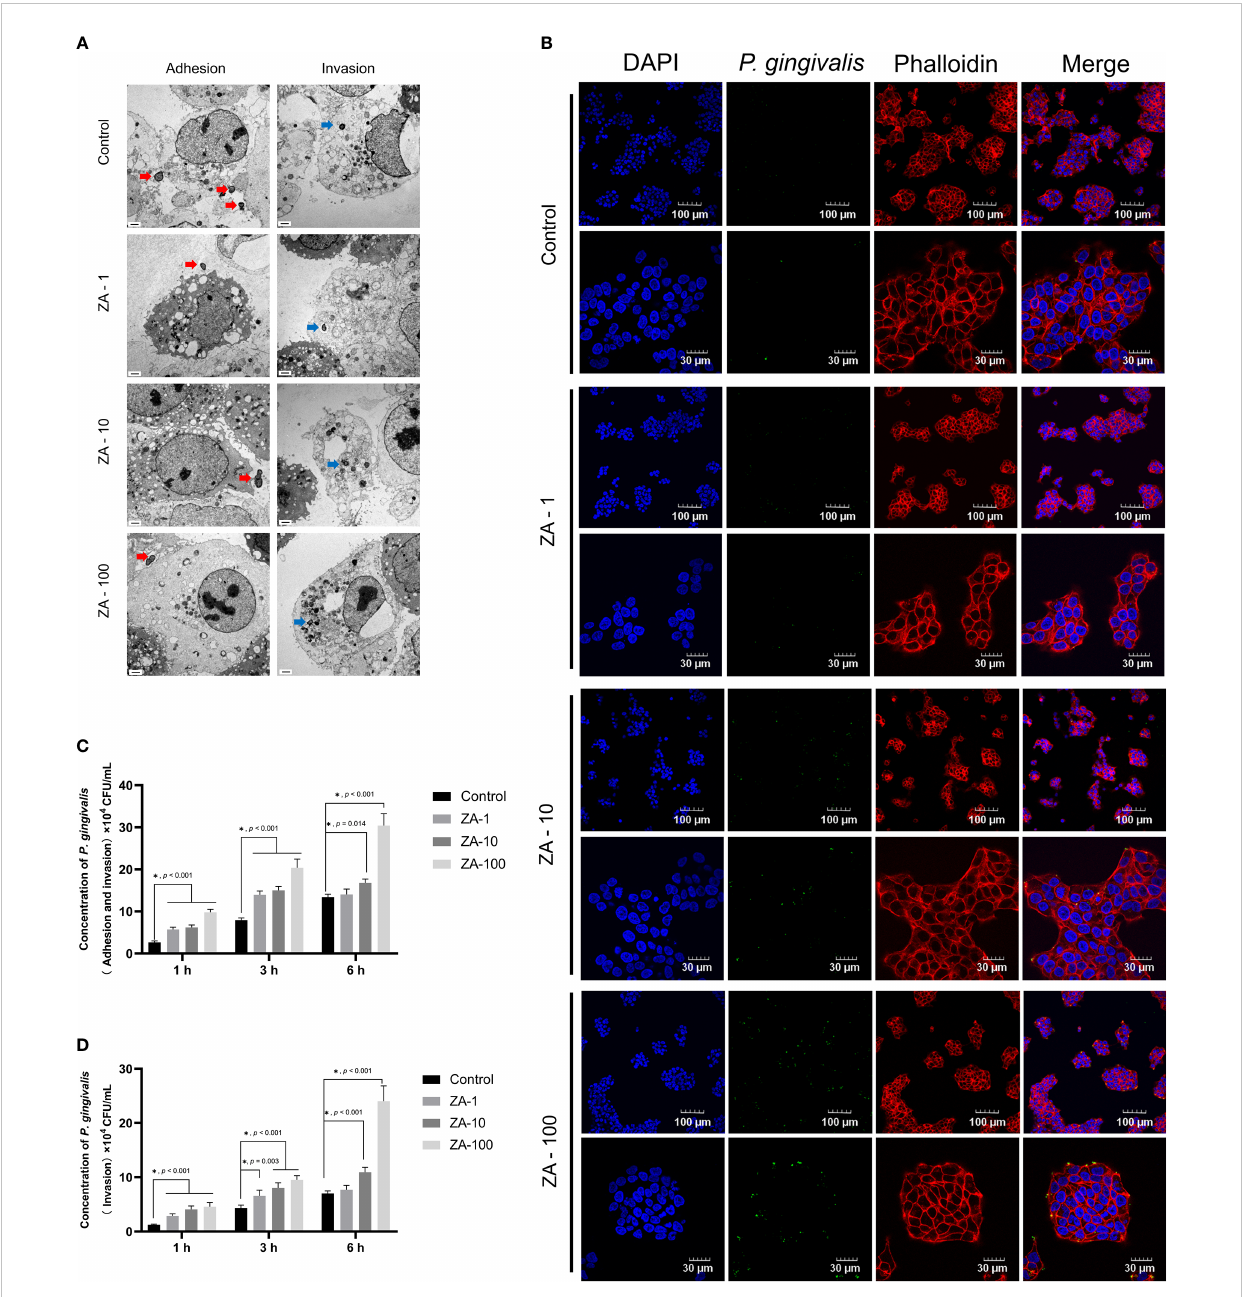
FIGURE 2 The process of P. gingivalis infecting HGECs in the presence of different concentrations of ZA in vitro . (A) The representative TEM images of in-vitro infection of HGECs by P. gingivalis of all groups. The red arrows indicate the P. gingivalis adhering to the surface of HGECs. The blue arrows indicate the P. gingivalis having invaded into HGECs. Scale bars = 1 m m. (B) The representative immuno fl uorescence images of P. gingivalis infecting HGECs for 6 h at different magni fi cations of all groups. The cell nucleus, blue fl uorescence; the cytoskeleton, red fl uorescence; P. gingivalis , green fl uorescence. Scale bars were shown in the images. (C) The internalization assay results of total attached and internalized P. gingivalis of HGECs in all groups at 1 h, 3 h, 6 h. n = 4 at each time point. (D) The internalization assay results of only internalized P. gingivalis of HGECs in all groups at 1 h, 3 h, 6 h. n = 4 at each time point. Values represent mean ± SD. Control, ZA-1, ZA-10, ZA-100 represent 0 m M ZA, 1 m M ZA, 10 m M ZA, 100 m M ZA respectively. *p<